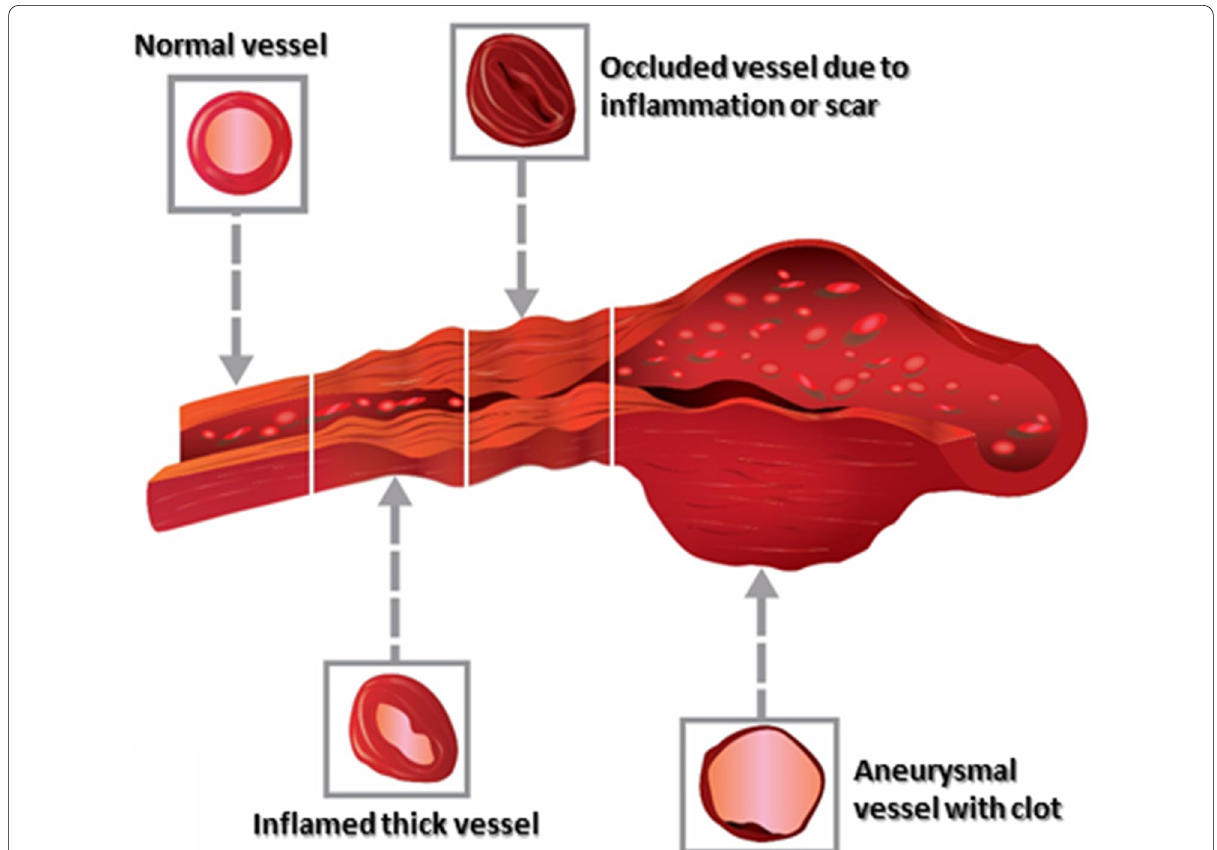
Fig. 2 Schematic illustration on the spectrum of vasculitis related damage on the vessel